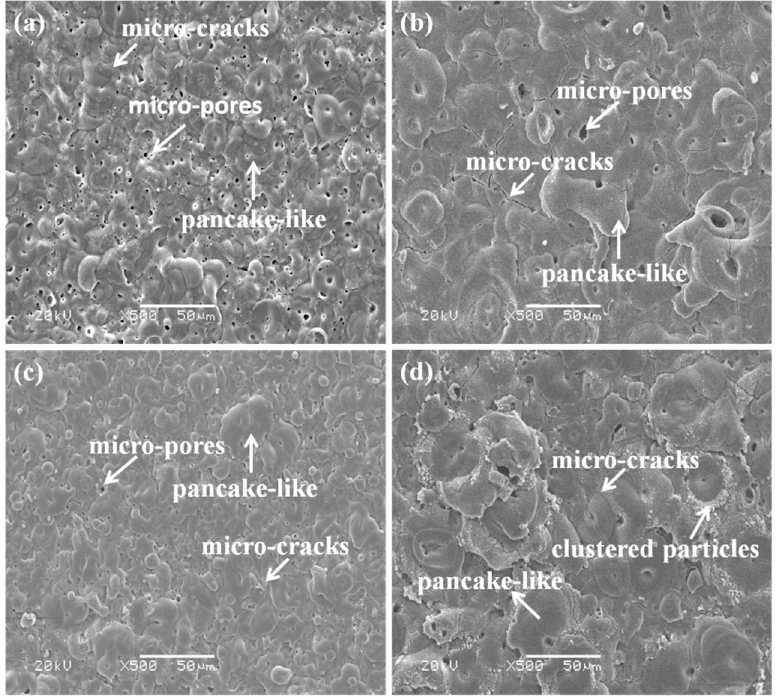
Figure 2. SEM morphologies of the surface coatings prepared from different electrolytes with different treating time: ( a , b ) P30 and P60 coatings; ( c , d ) Al30 and Al60 coatings.